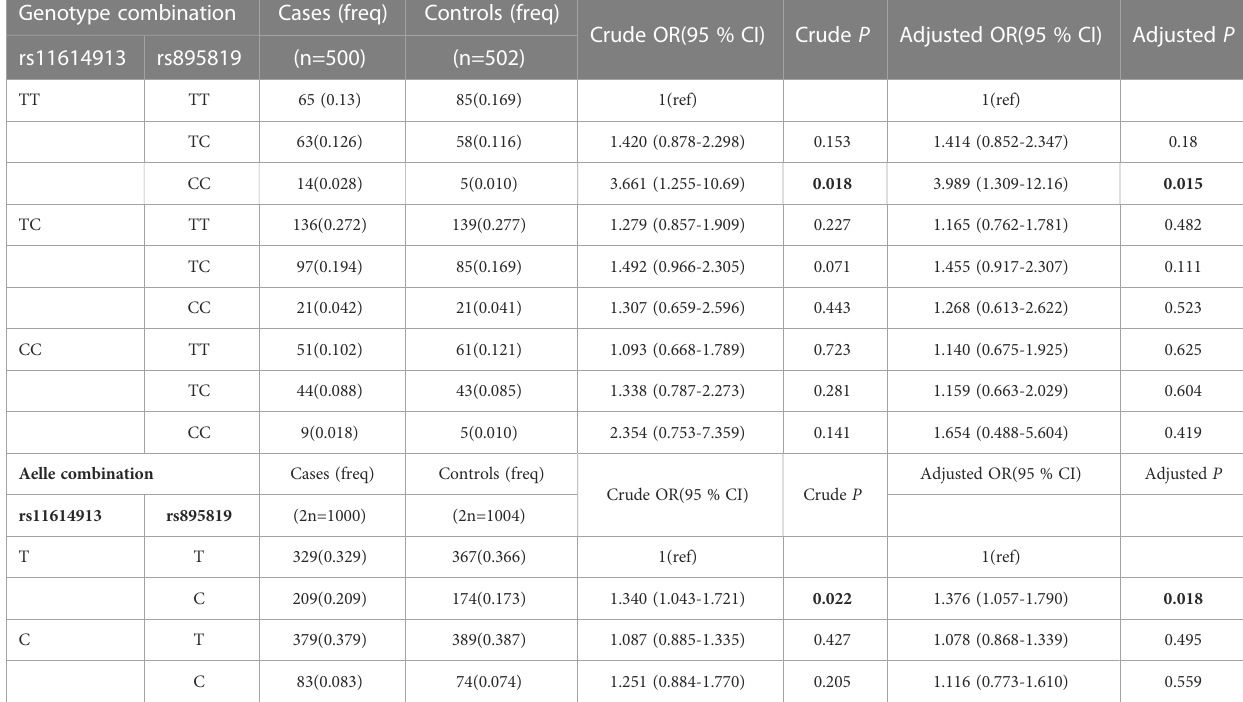
TABLE 4 The associations between combined genotype/aelle and GDM risk.